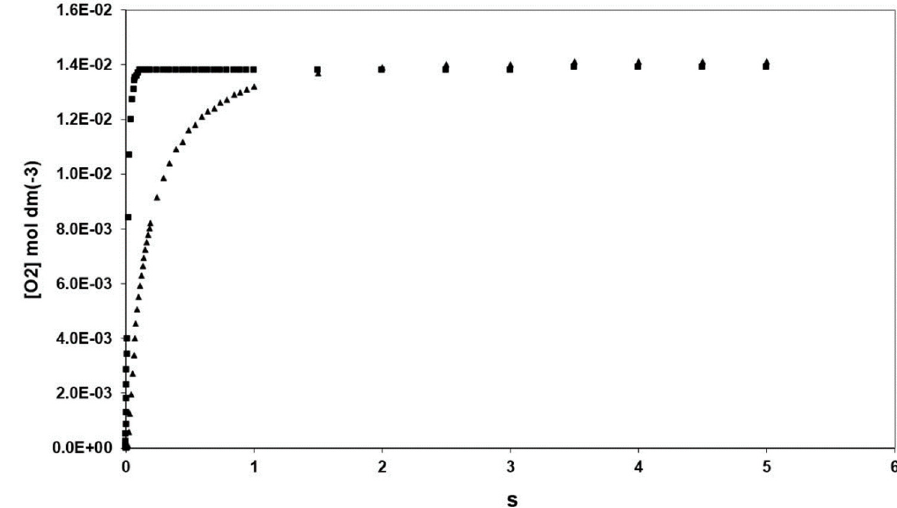
lower and upper limits of the concentration range in the experiments.